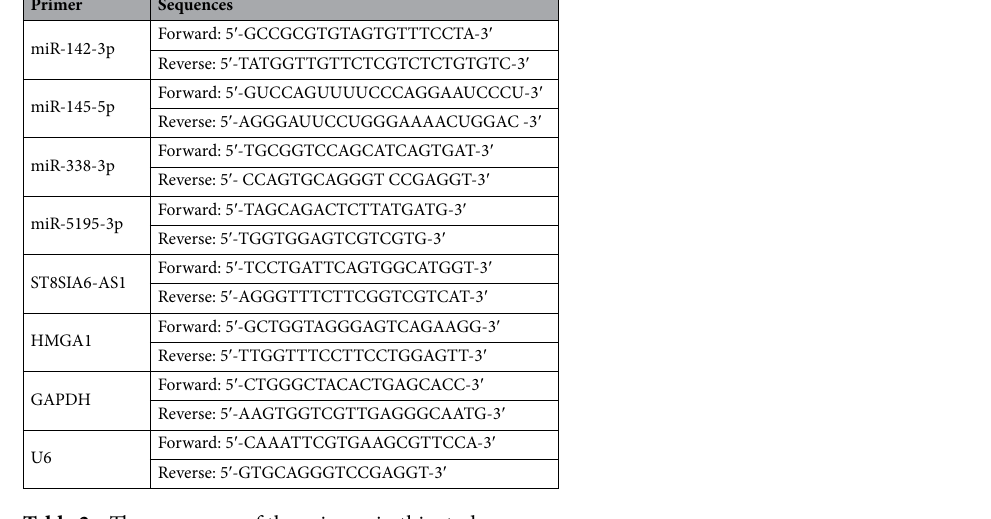
Table 2. The sequences of the primers in this